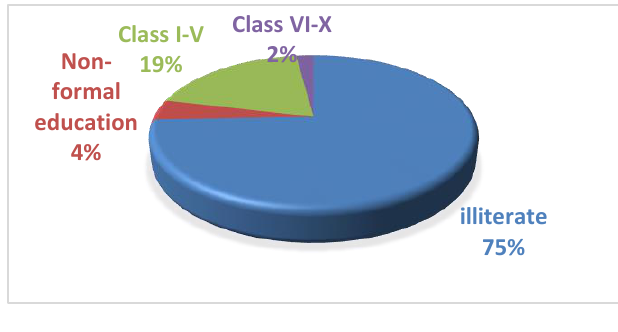
Distribution of education of injured children, n=234 Fig-3 shows that out of 234 respondents, 174(75%) of injured children were illiterate, 10(4%) were non-formally educated, 45(19%) were class I-V learned and 5(2%) were class VI- X learned.